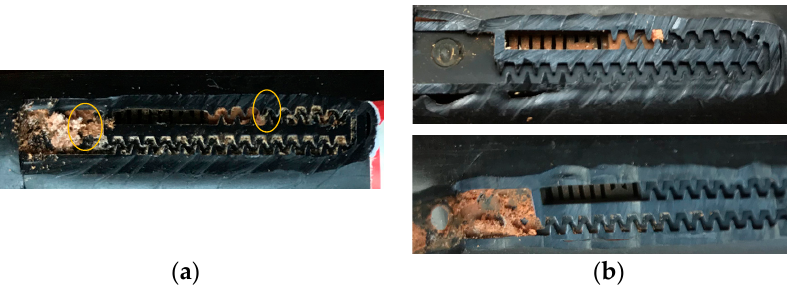
Figure 8. Residual sediments in the labyrinth channel of emitters (yellow parts indicate that the clogging substances are other impurities, not sediments). ( a ) Emitters with flushing treatment; ( b ) emitters without flushing treatment.